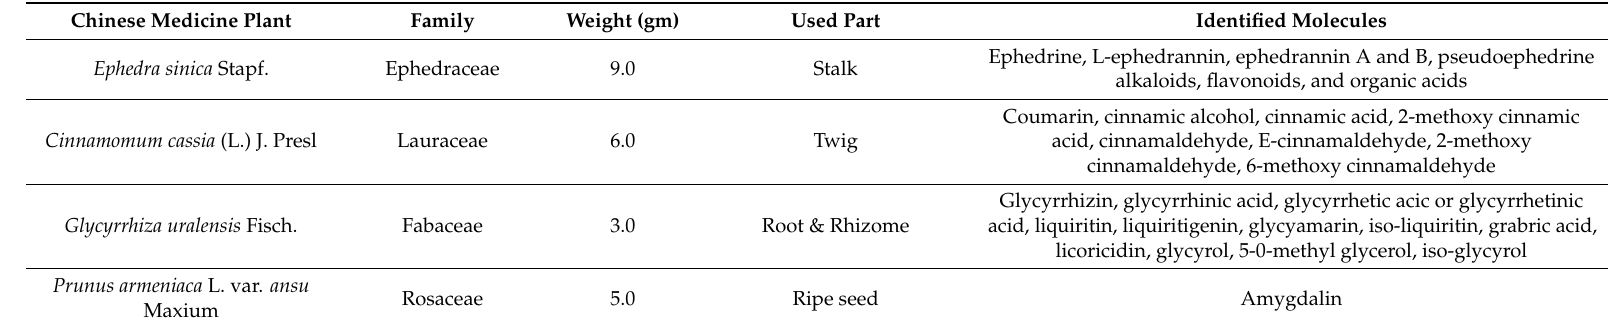
Table 2. Composition Ma-Huang-Tang (MHT; Maoto in Japan)